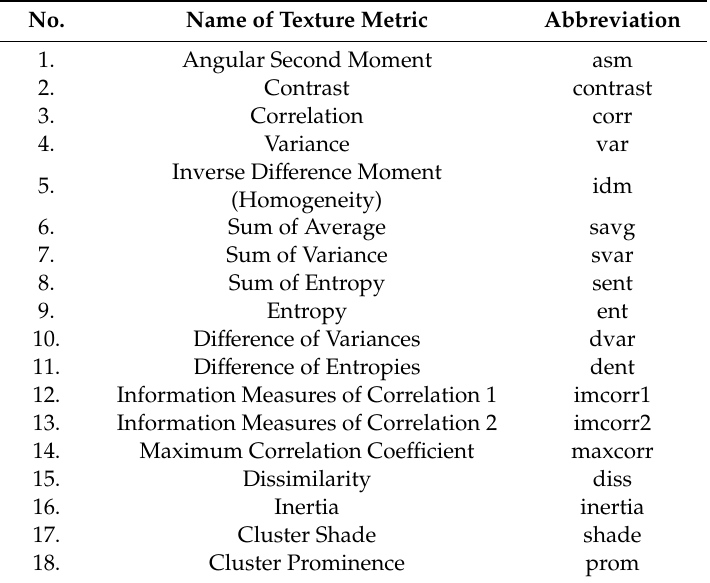
Table 1. List of texture metrics and abbreviations used as variables in supervised forest classification from satellite imagery for the Bago Region of Myanmar based on [54,55].